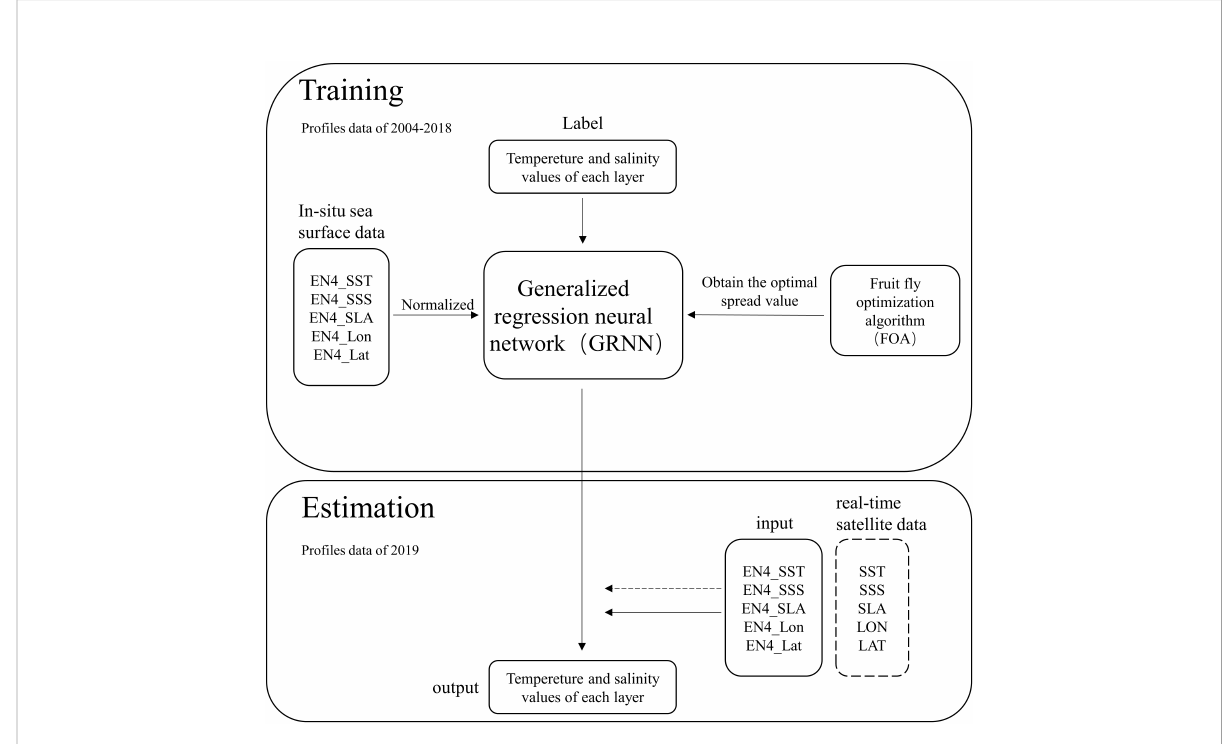
FIGURE 2 The fl ow chart of the reconstruction of 3D T/S pro fi